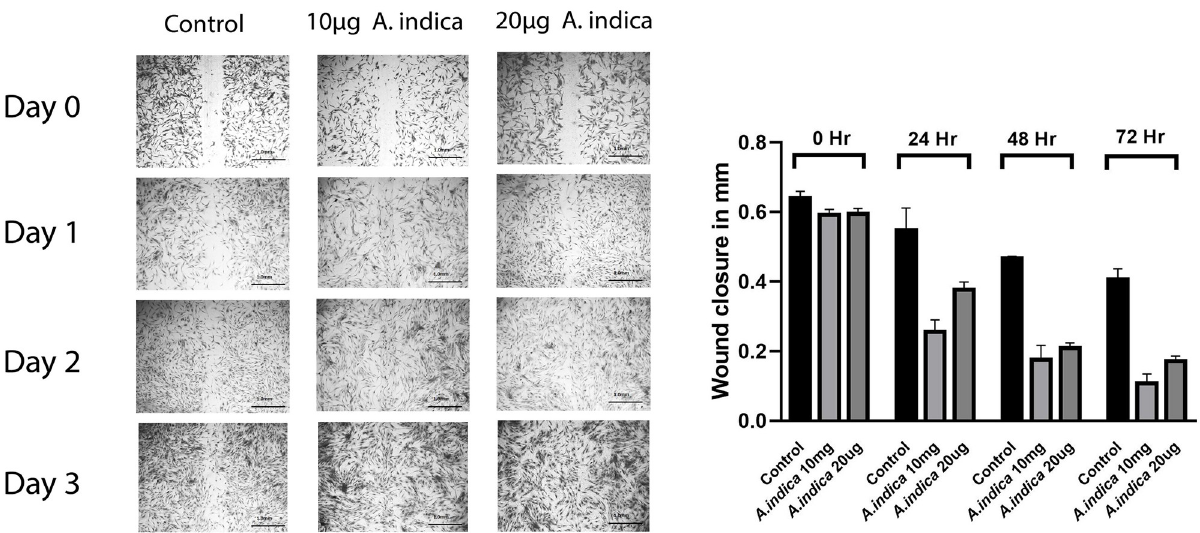
Fig 2. Wound healing assay of hADMSCs performed at 24hr time interval at 500 μ m scale and 40x magnification for three days where (A) represents the control and preconditioned hADMSCs (A.I represents Aesculus indica ), while (B) represents the wound size in millimeter (mm) for three days at 24hrs time frame using ImageJ